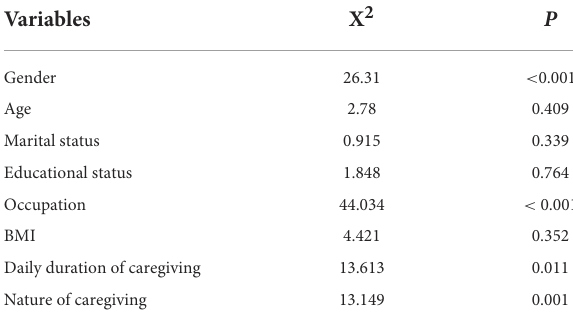
TABLE 3 Association between Level of disability and Participants’ Characteristics